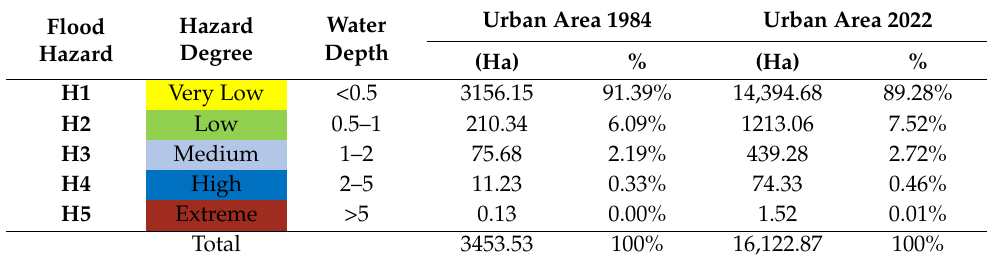
Table 6. Urban areas exposure, 1984.